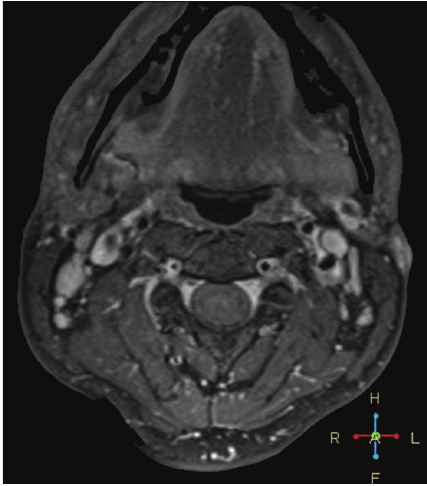
Figure 2: Axial source image of MRA performed just below the foramen lacerum showing the characteristic half-moon appearance of the false lumen separated by a thin flap from the oval-appearing true